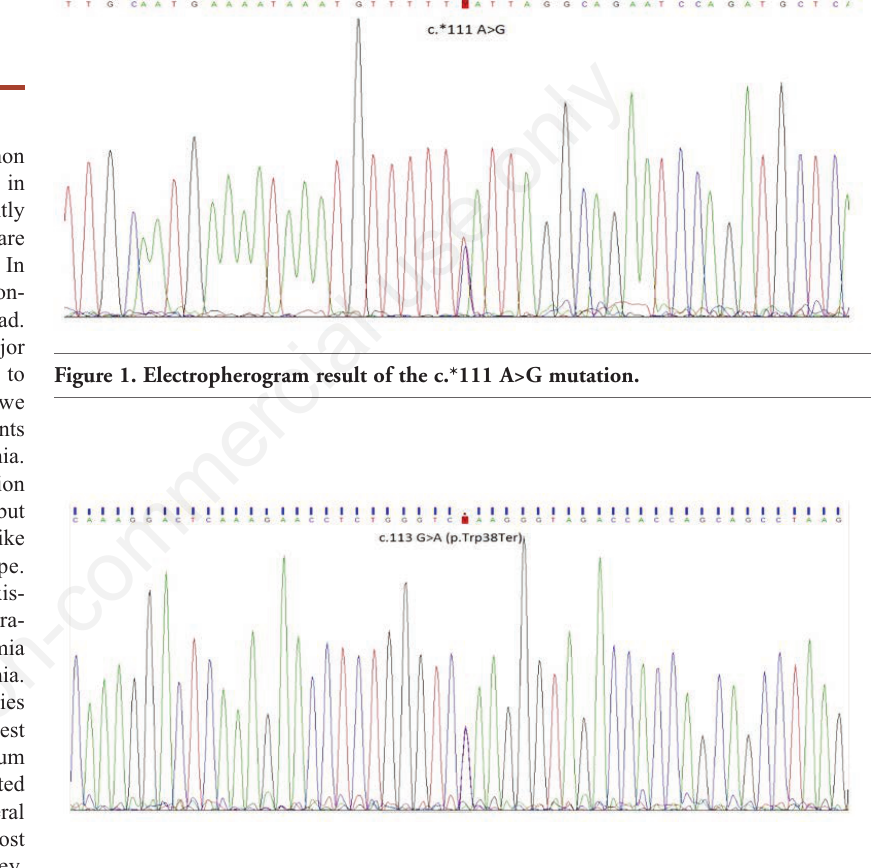
Figure 2. Electropherogram result of the c.113 G>A mutation